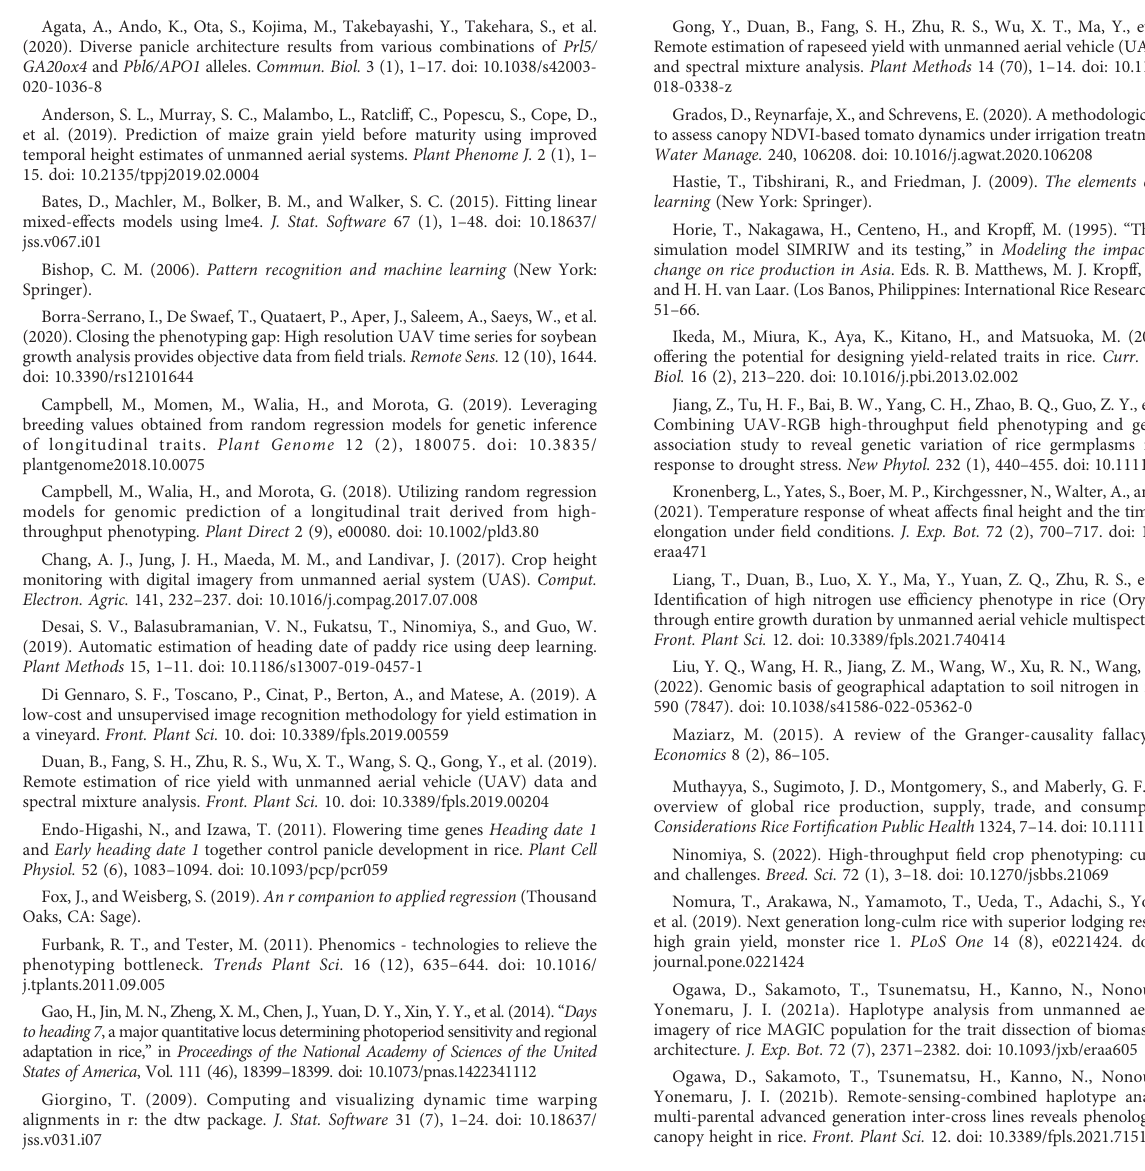
SUPPLEMENTARY FIGURE 4 Visualization of the LME model for ADW. Left, proportion of 4 variance components; right top, BLUPs of cultivar and cultivar × year interactions of 30 cultivars; right bottom, BLUPs of 3 years. Cultivars are sorted by d 1 . SUPPLEMENTARY FIGURE 5 Visualization of the LME model for SLW. Left, proportion of 4 variance components; right top, BLUPs of cultivar and cultivar × year interactions of 30 cultivars; right bottom, BLUPs of 3 years. Cultivars are sorted by d 1 . SUPPLEMENTARY FIGURE 6 Visualization of the linear mixed effects model for (A) d 1 and (B) d 1 temp . Left, proportion of 4 variance components; right top, BLUPs of cultivar and cultivar × year interactions of 30 cultivars; right bottom, BLUPs of 3 years. Cultivars are sorted by d 1